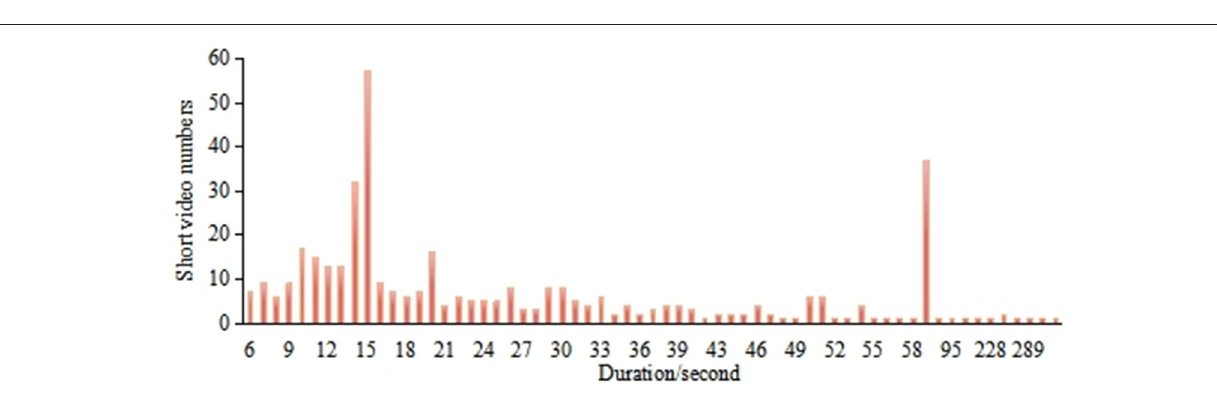
( Figure 10 ): (1) “source” is a short video focusing on